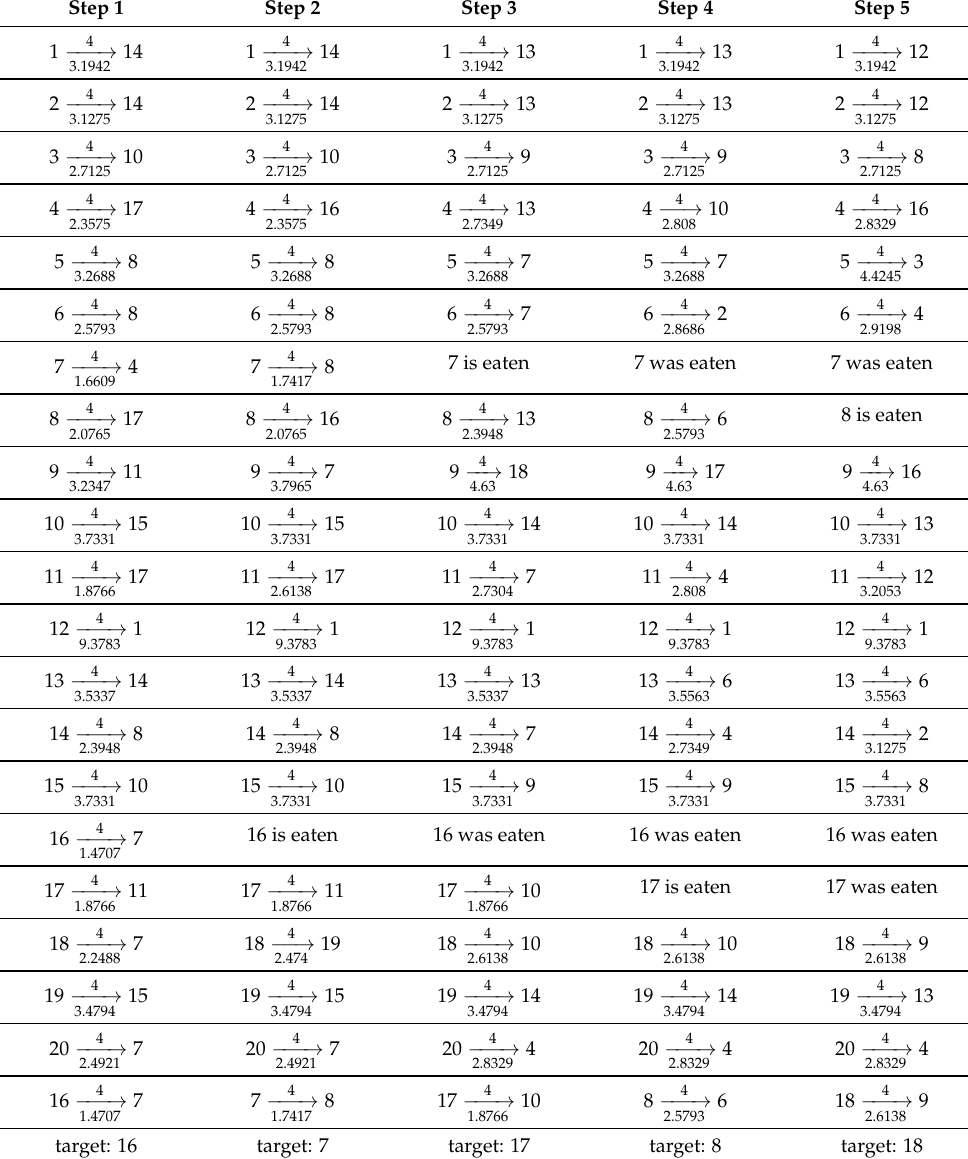
Table 2. Partial computation (5 steps) for LMRFT-based optimal foraging path among 14 steps for animal